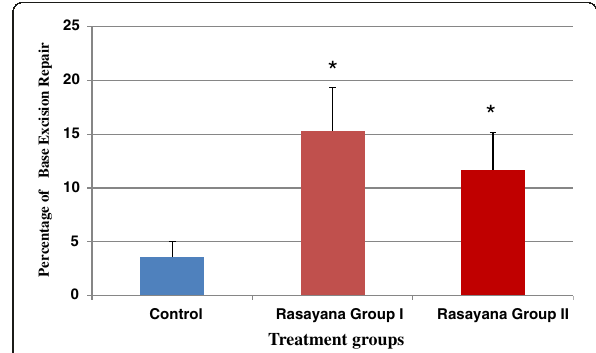
Figure 2 Constitutive base excision repair in BR-treated animals after 24 h recovery time. Constitutive repair in Rasayana 1 and Rasayana 2 treated animals are significantly (p <0.05) higher compared to control animals.